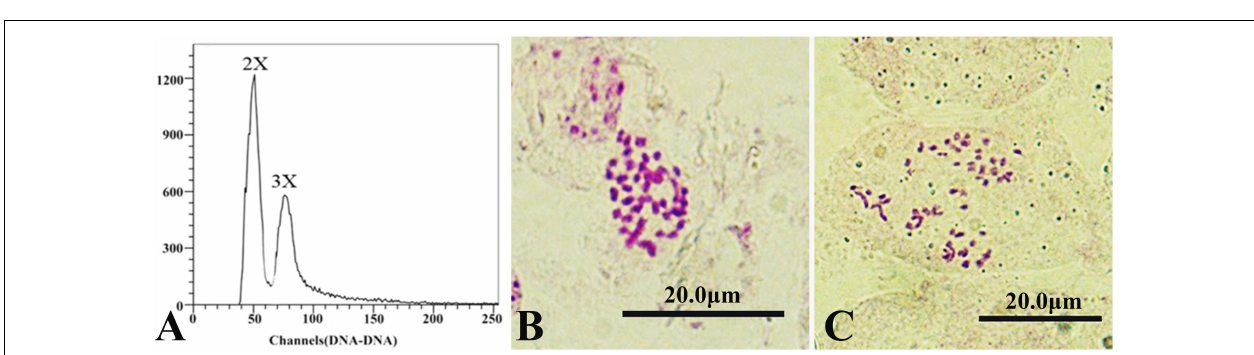
FIGURE 3 | Flow cytometric analysis and somatic chromosome counting of the offspring derived from pollen chromosome doubling induced by colchicine in P. canescens (scale bar = 20 µ m). (A) Flow cytometric analysis of the mixed simple of a diploid plant and a triploid plant; (B) Chromosome number of the diploid (2n = 2x = 38); (C) Chromosome number of the triploid (2n = 3x =